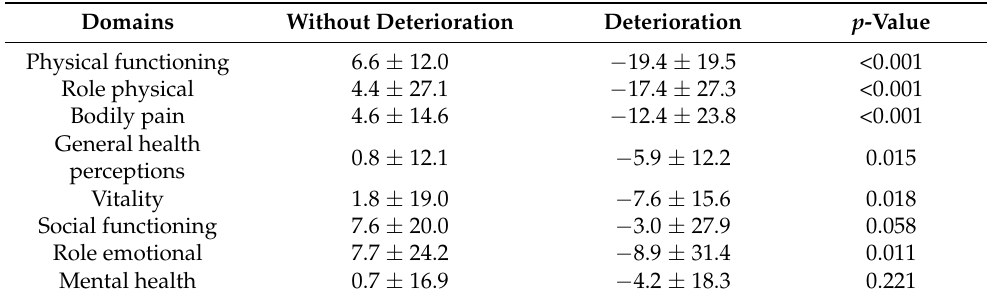
Table 3. Univariate comparison of the change in SF-36 domain scores after 2 years between patients with and without PCS deterioration.